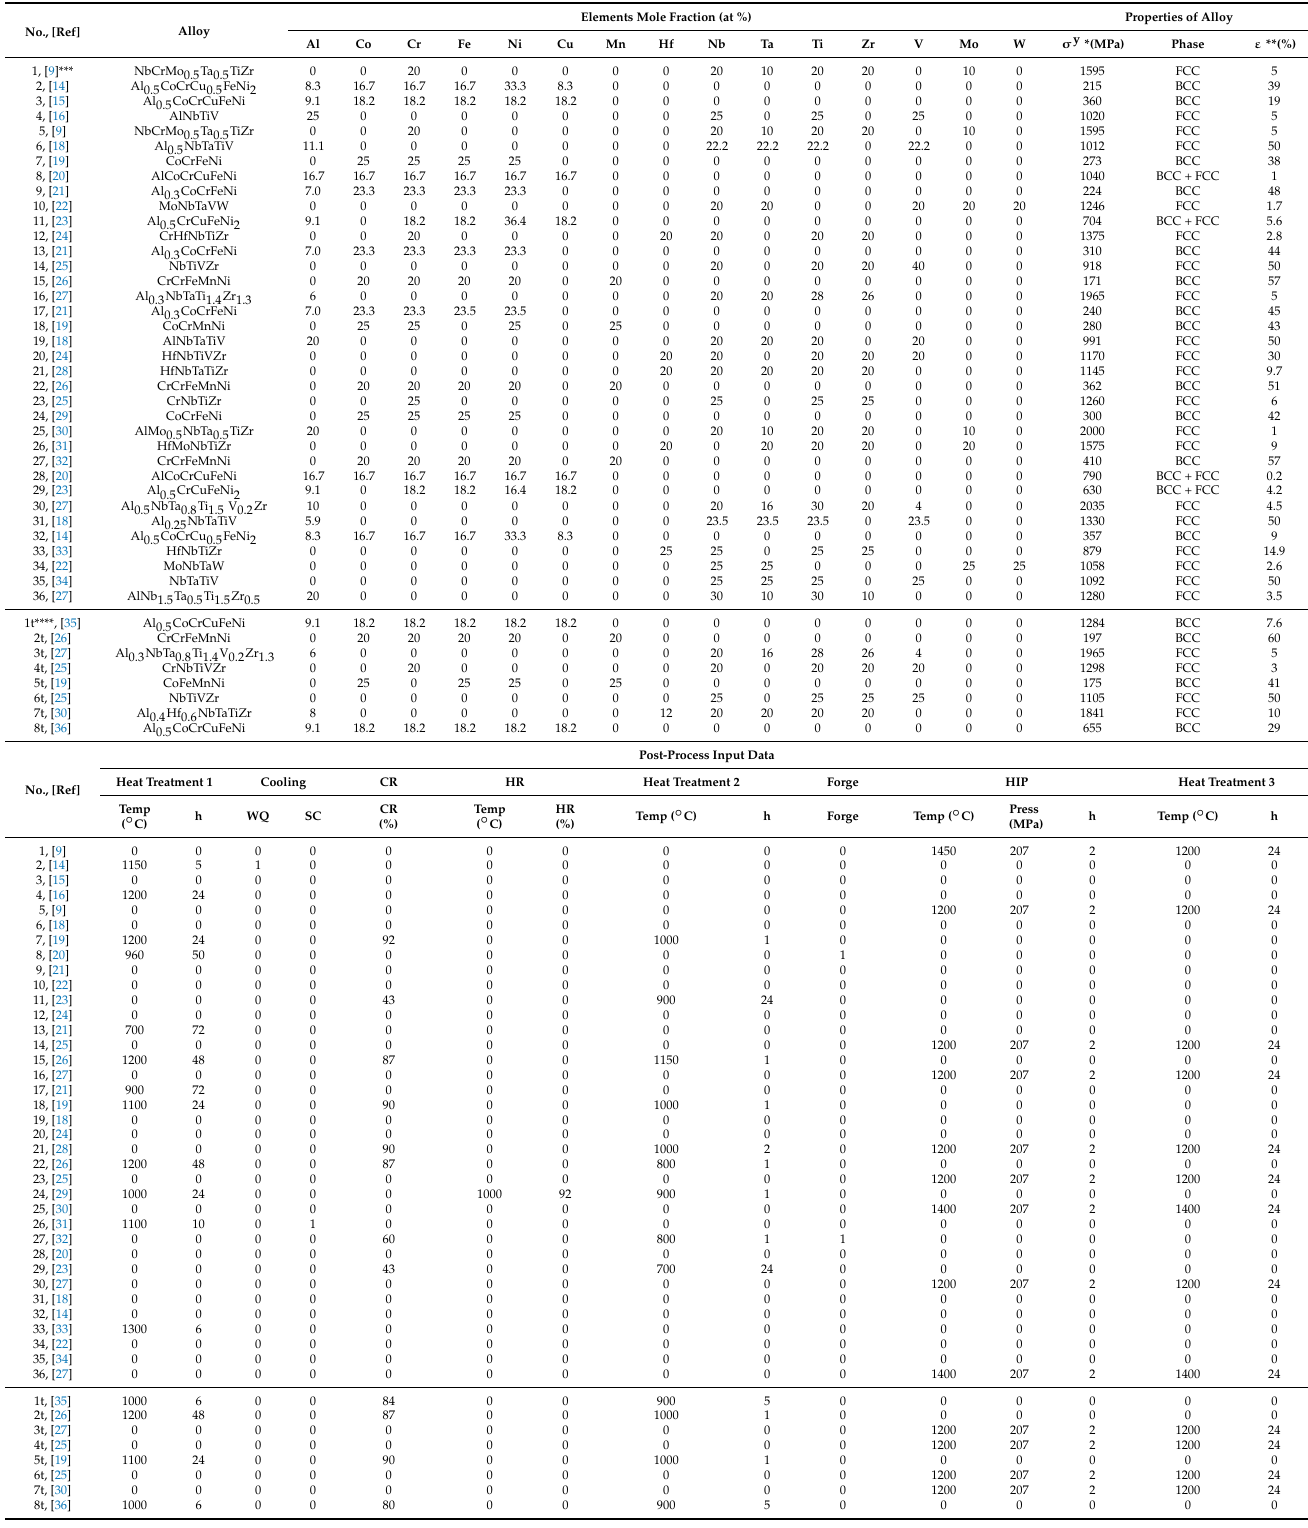
Table 1. Collected data set of high-entropy alloys mole fraction with post-process conditions and properties results data used for input and output in an artificial neural network prediction